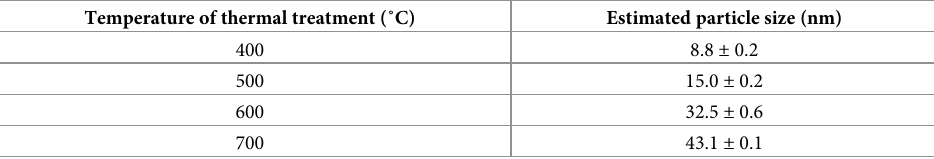
Table 2. Estimated particle sizes of TiO 2 samples after thermal